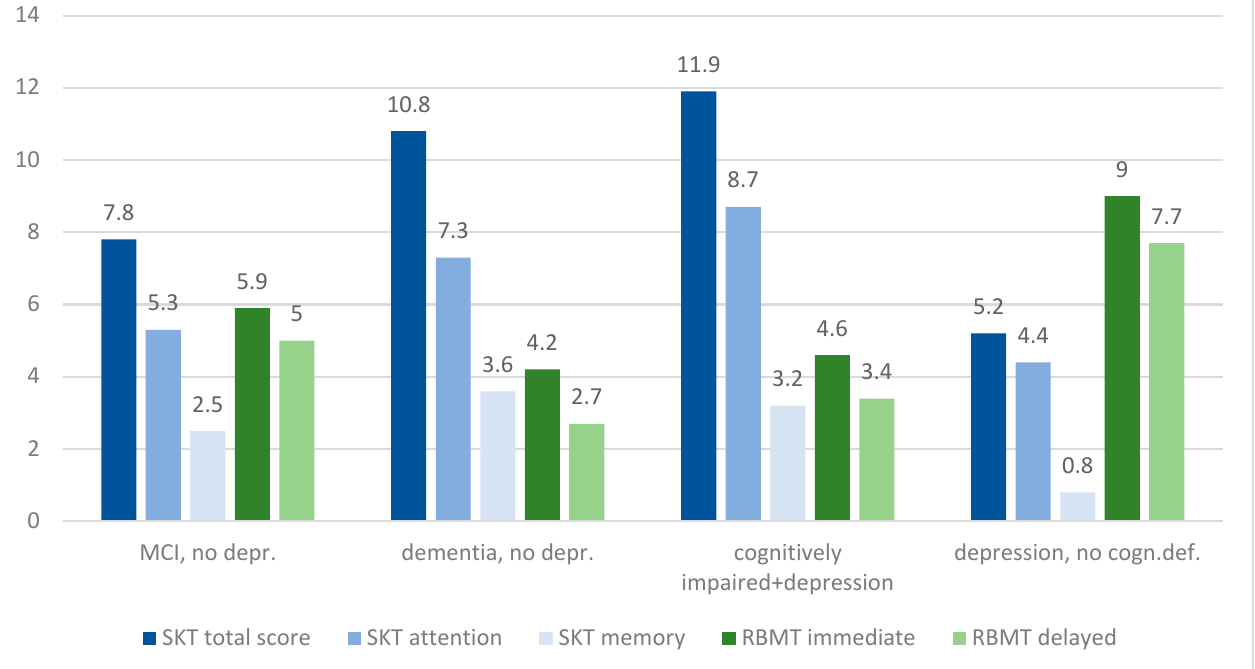
Figure 3. Test profiles of the individual diagnosis groups.